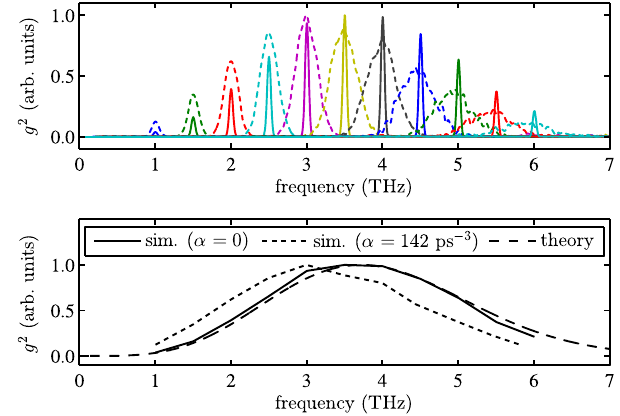
FIG. 5. Top: narrowband form factors resulting from start-to- end simulations with (dotted) and without third-order dispersion (solid) for different modulation frequencies (see text for details). Bottom: gain curves extracted from the simulated form factors and according to theory (see Fig.